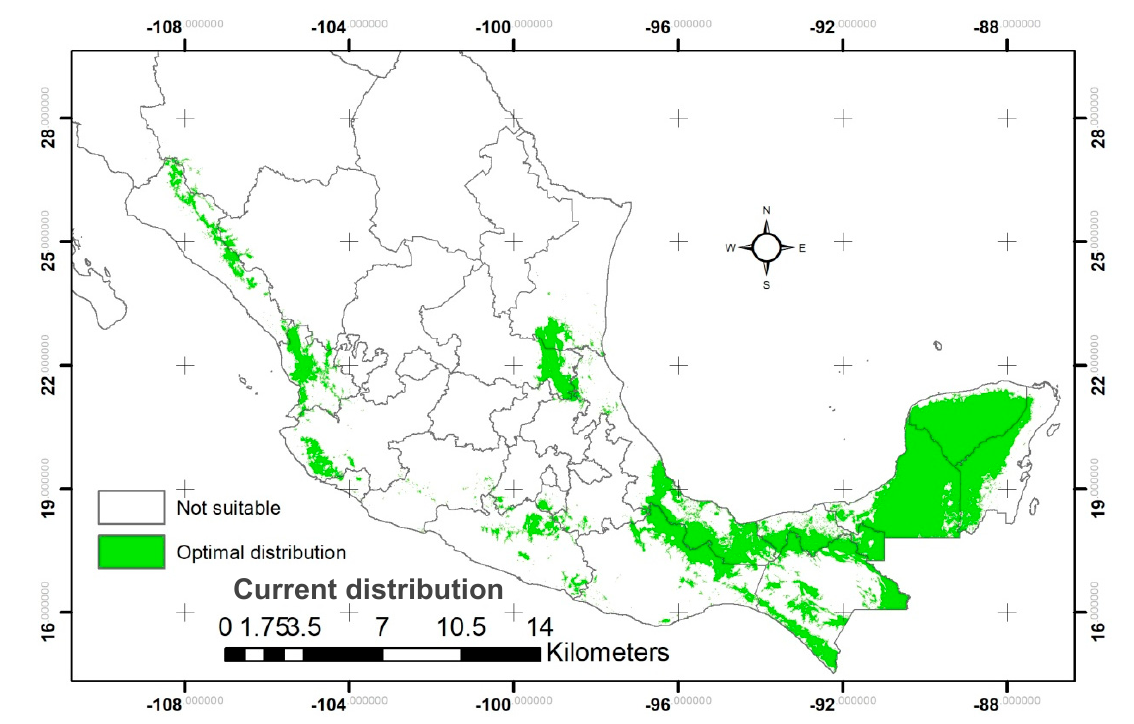
Figure 1. Current distribution of C. odorata . In green, the optimal distribution according to the optimum germination temperature range.